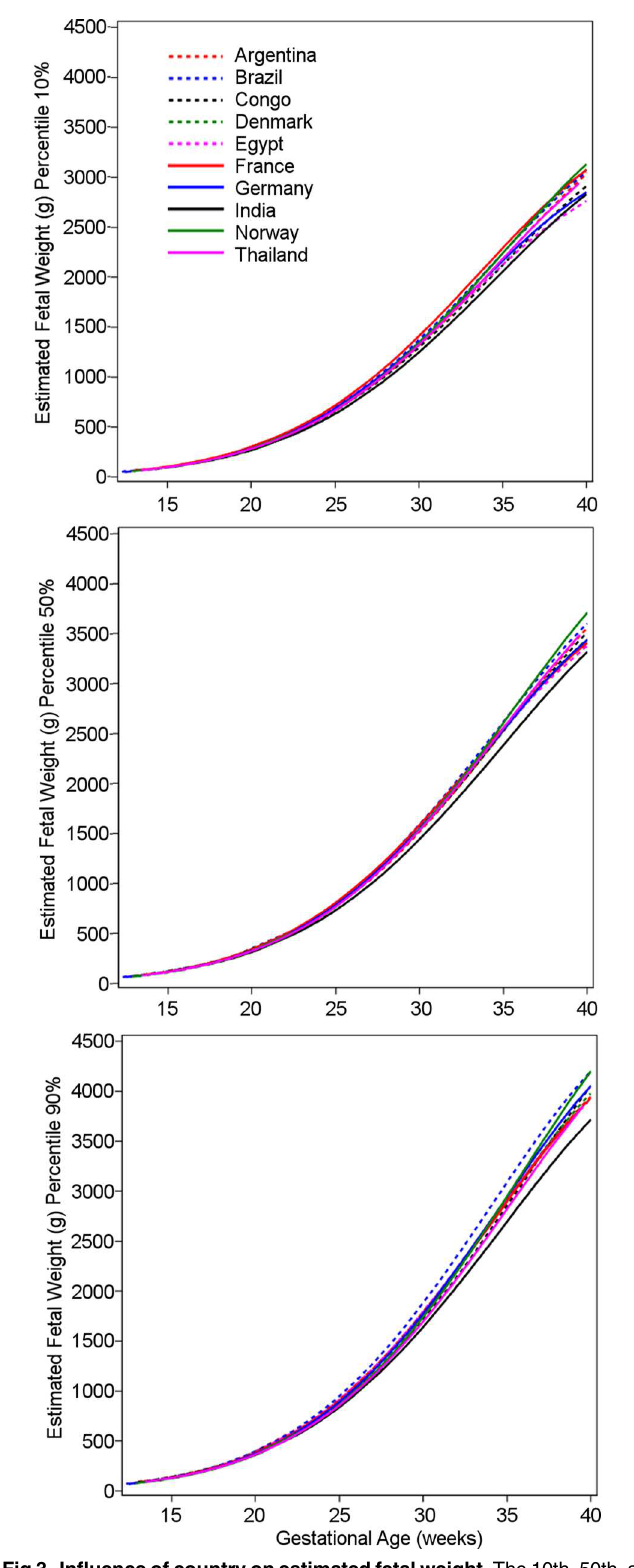
Fig 3. Influence of country on estimated fetal weight. The 10th, 50th, and 90th percentilesfor estimated fetal weight in grams for the ten participating countries, with variation due to country becomingmore obvious towards the end of gestation. Congo, Democratic Republicof the